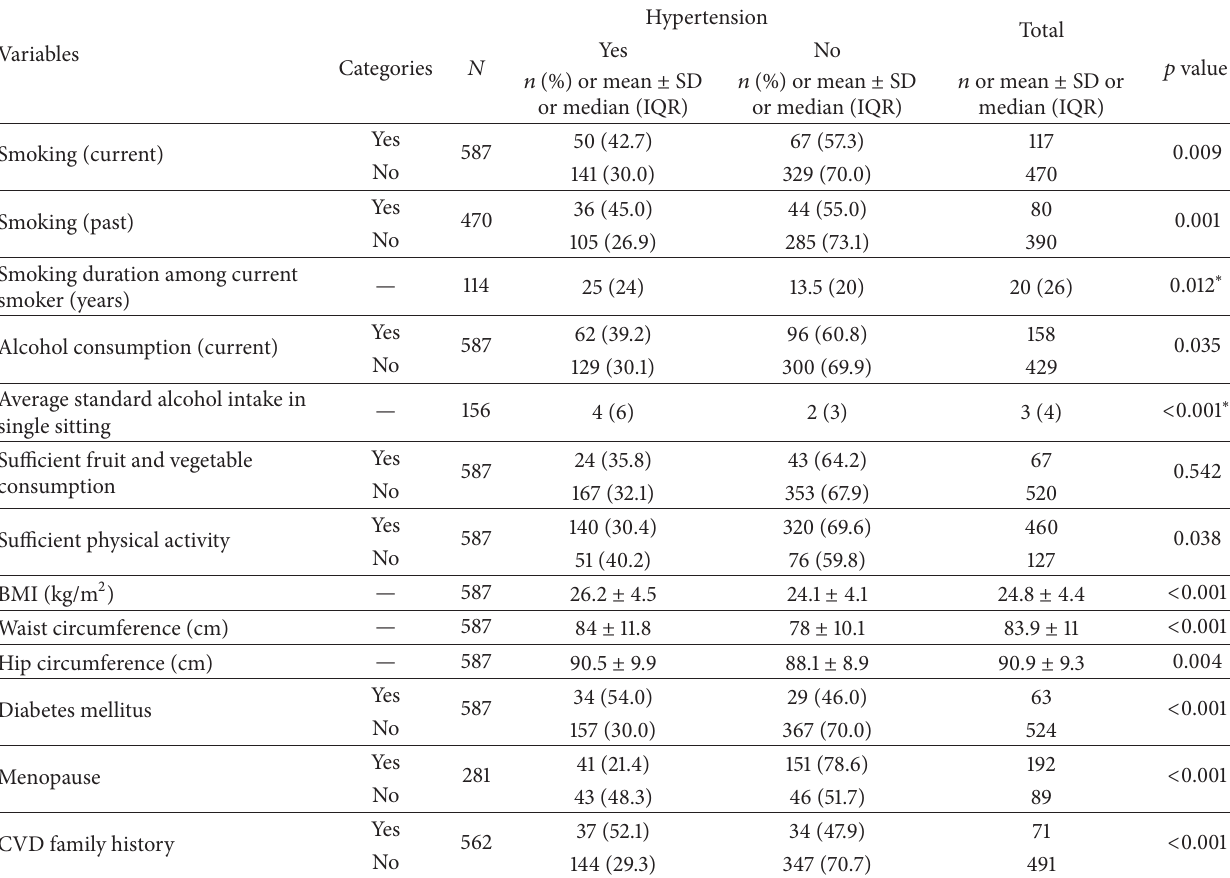
Table 3: Association of behavioral, metabolic, and other factors with hypertension.